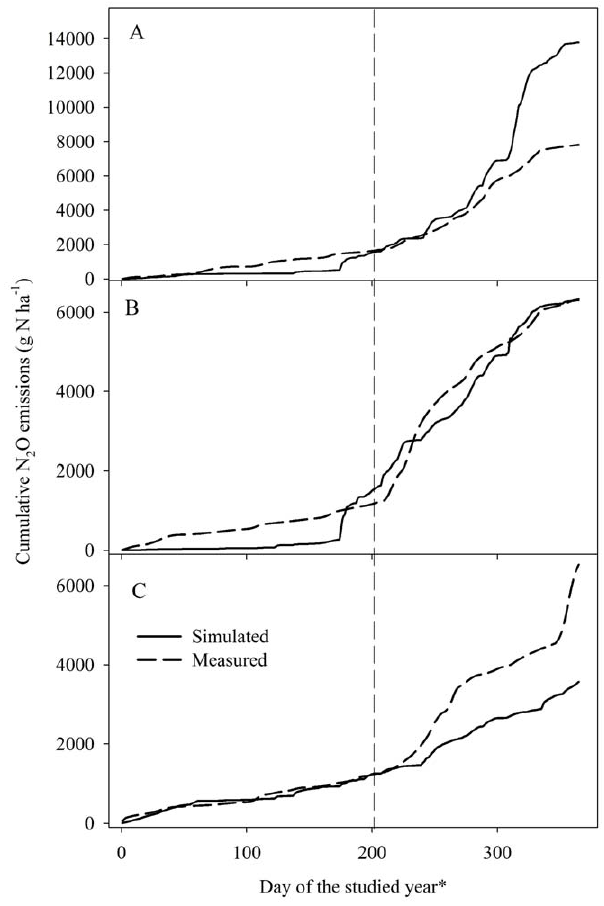
Figure 2. Cumulative N 2 O emissions. Cumulative N 2 O emissions over the studied year for (A) GG + FN, (B) GWC + FN, and (C) GWC-FN. The vertical broken line divided the studied year into non-grazing period (left) and grazing period (right). *The studied year composed of